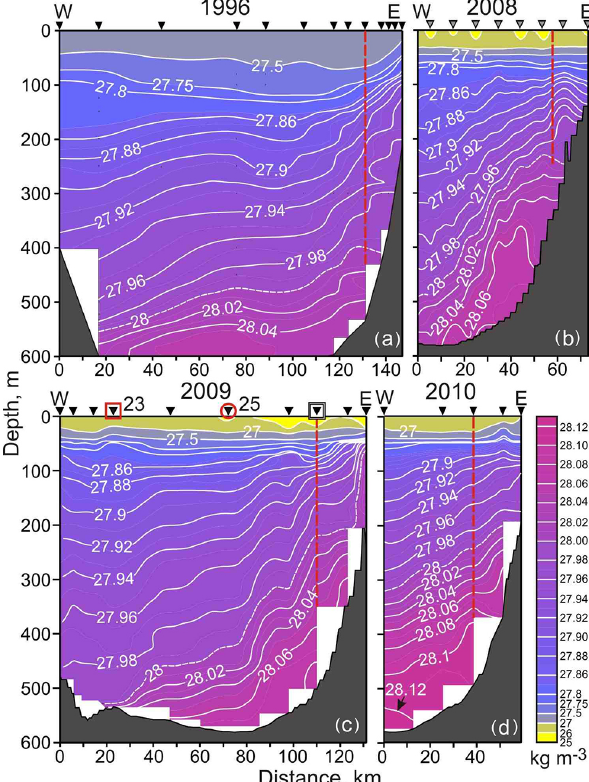
Figure 6. The 10m binned cross-trough sections of potential den- sity ( σ –zero, kgm − 3 ) along 81 ◦ N for (a) July 1996, (b) Septem- ber 2008, (c) September 2009 and (d) October 2010. Black and gray triangles on the top identify positions of CTD and XCTD stations, respectively. Following Fig. 2, the red square and circle and the white square identify stations taken through the core of the SFSBW inflow and outflow to/from the ST and mooring position, respectively, with their reference numbers on the top. Red dashed lines identify locations of the geostrophic velocity profiles shown in Fig. 7a. The white dashed line highlights the σ –zero=28kgm − 3 , which roughly corresponds to the core of the cooler fraction of BSBW (Dmitrenko et al., 2008a,